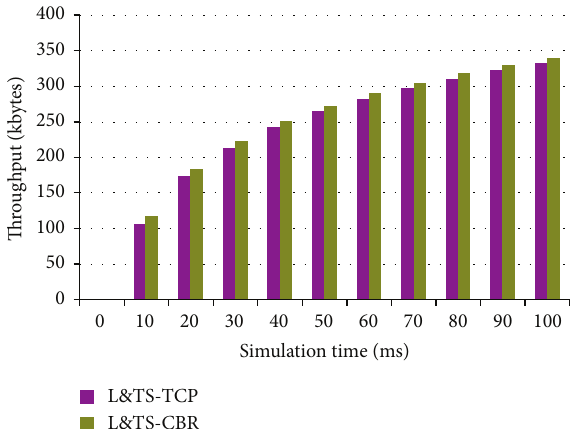
Figure 18: Throughput of L&TS with CBR and TCP models.